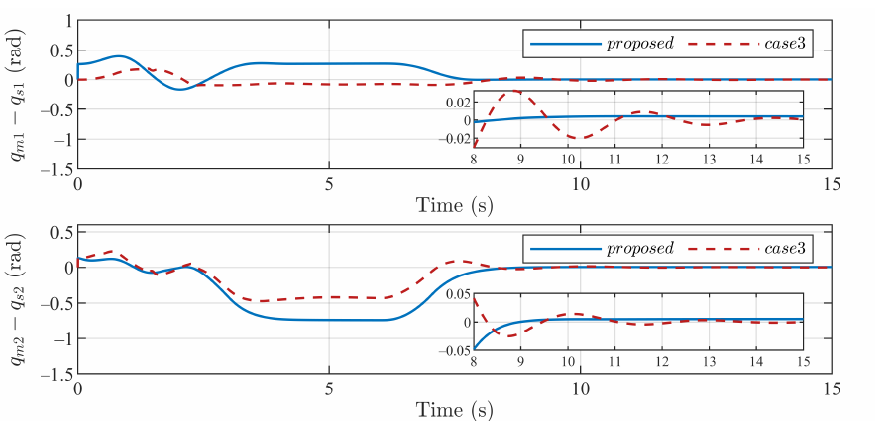
Figure 17. Comparisons of joint tracking errors with the proposed method and Case